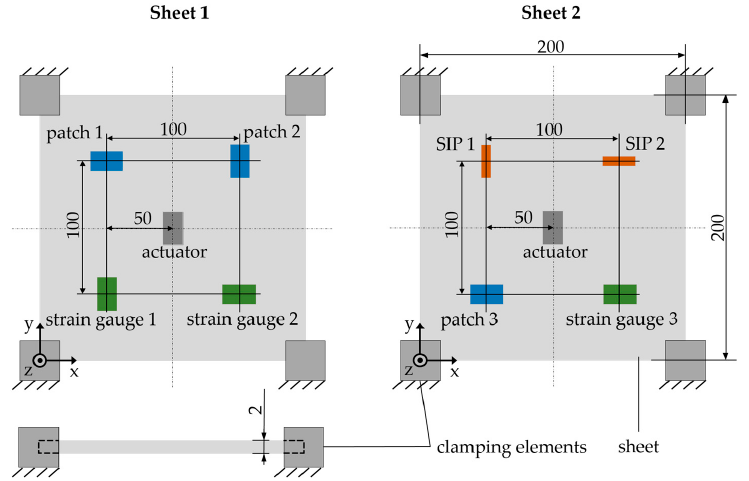
Figure 4. Sensor and actuator arrangement on the sheets (dimensions in